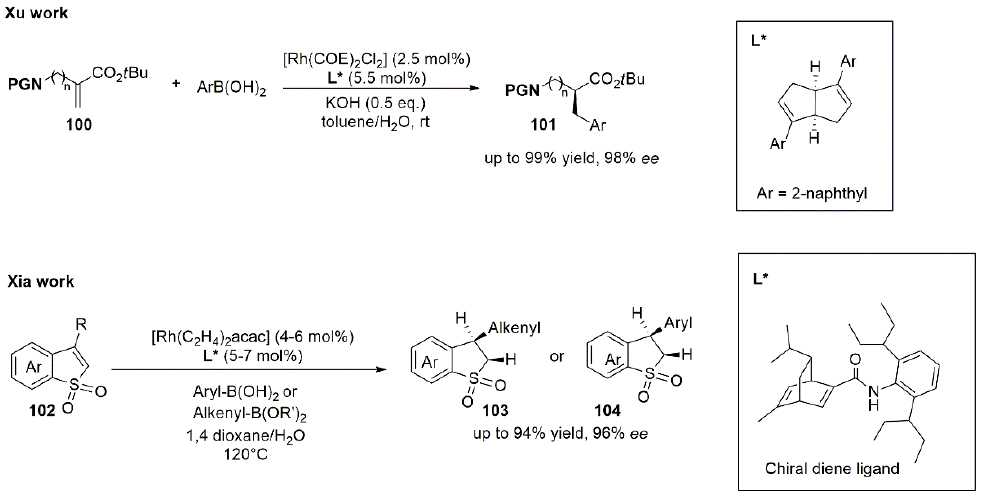
Figure 41. Diboron–water species as hydride source for the Rh-catalyzed asymmetric synthesis of α -aminoalkyl acrylates ( 101 ) (by Xu) and benzo[b]thiophene 1,1-dioxides ( 103 or 104 ) (by Xia).